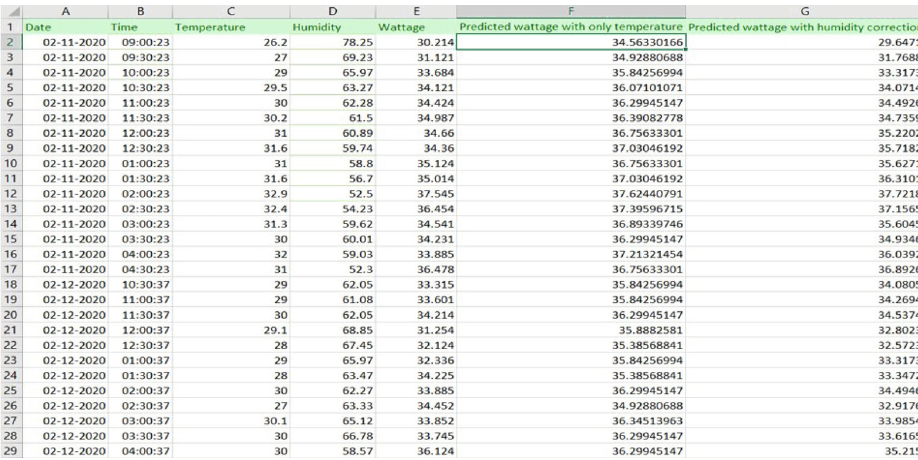
Figure 15: Comparison of measured and predicted results.